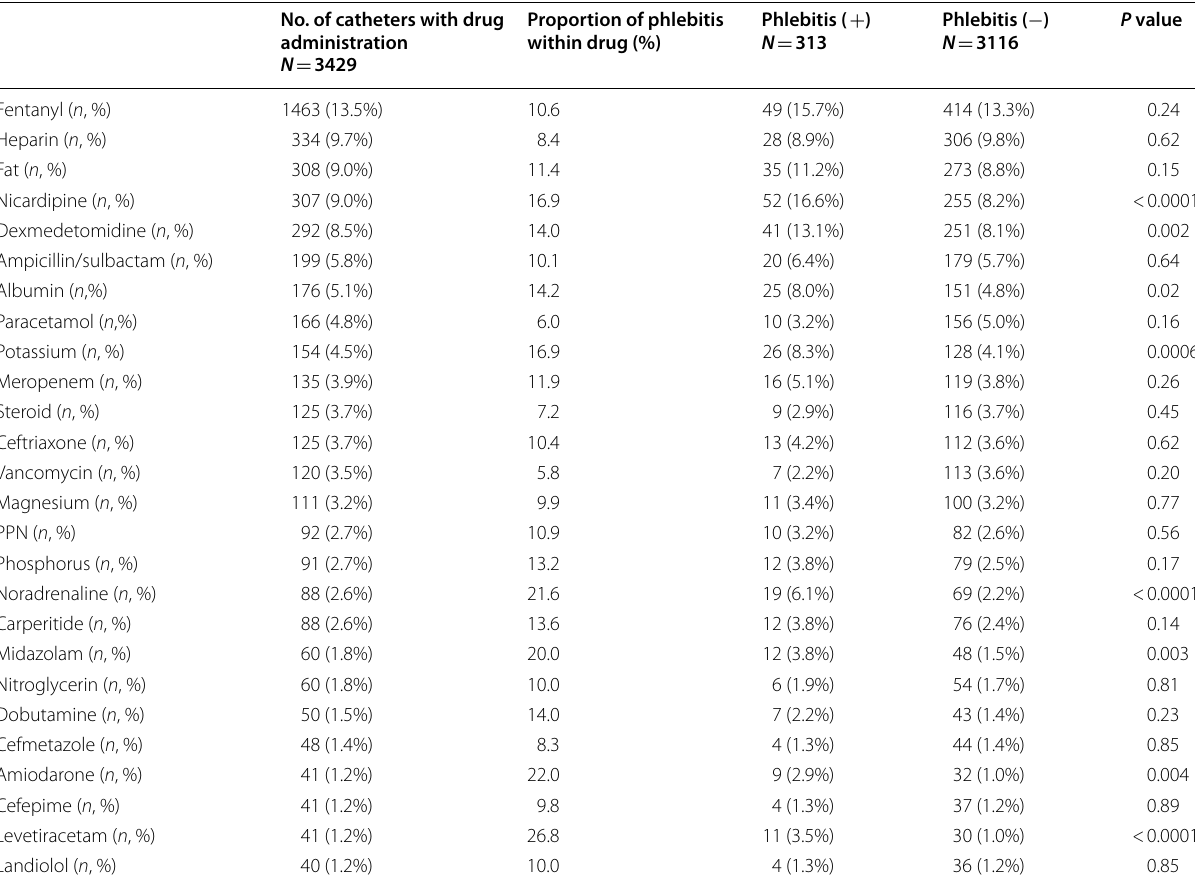
PIVC peripheral intravenous catheter, PPN peripheral parenteral